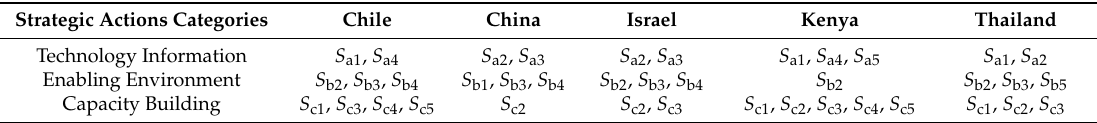
Table 2. Priority strategic actions for the promotion of technology transfer energy services priorities.